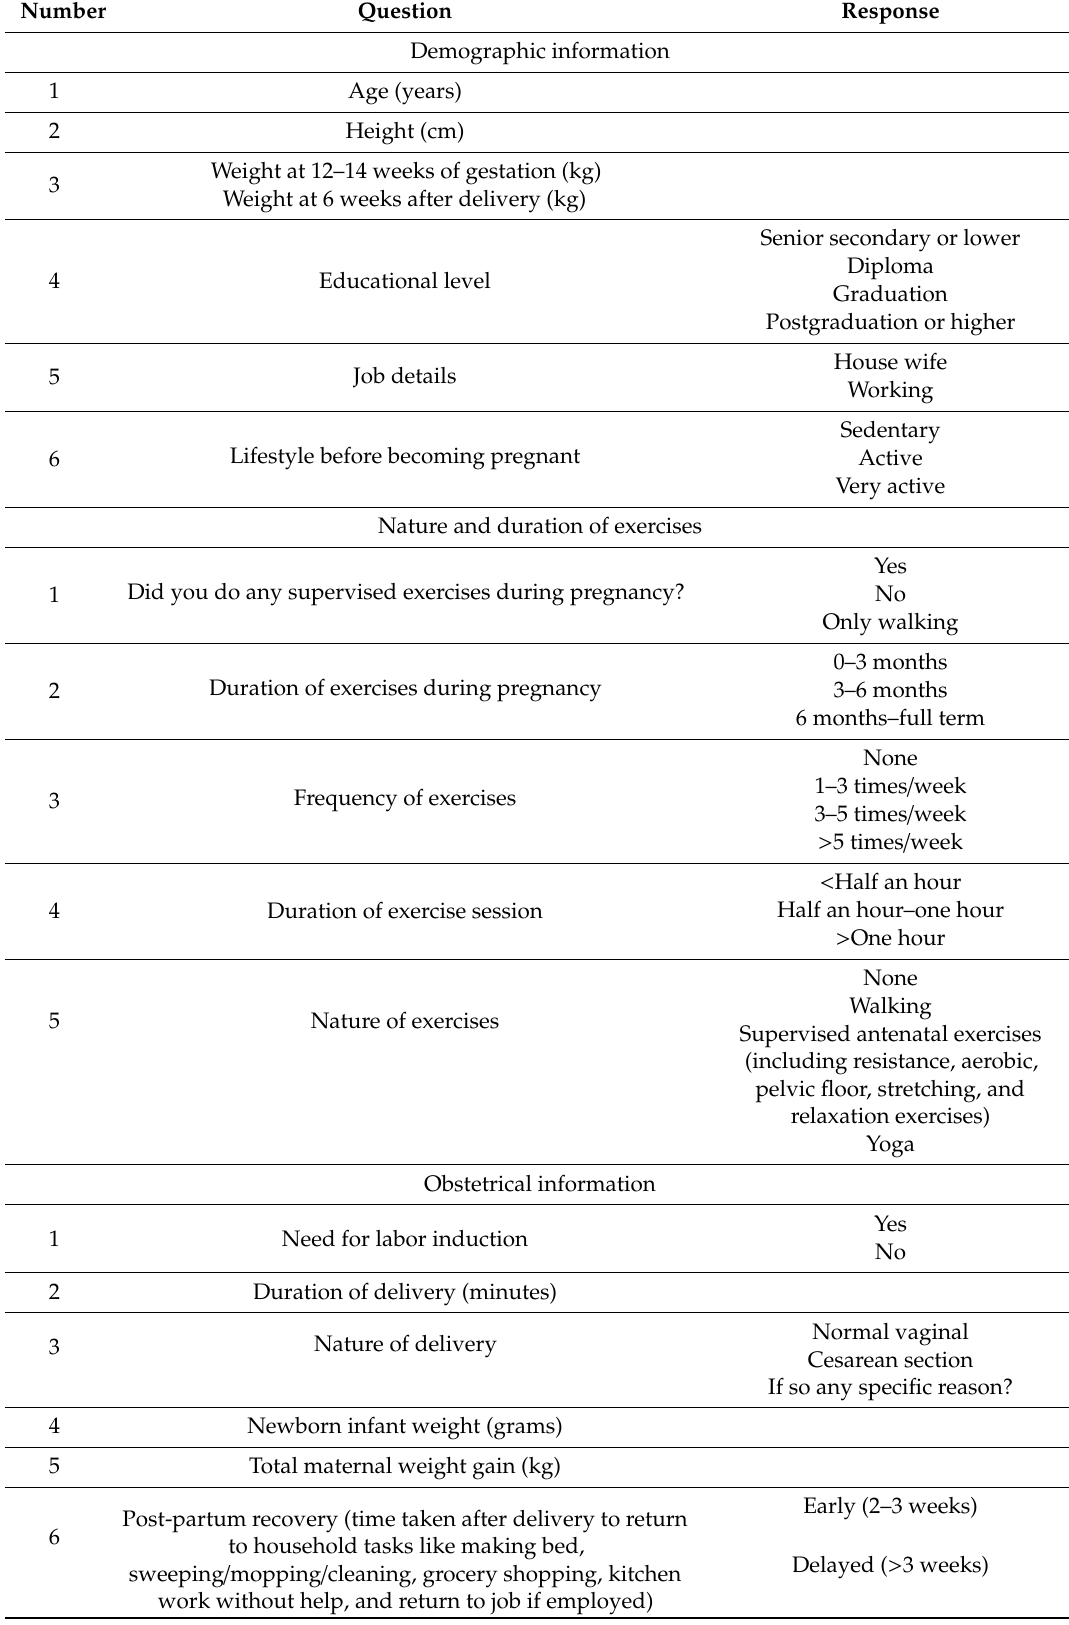
Table 1. Questionnaire used in the